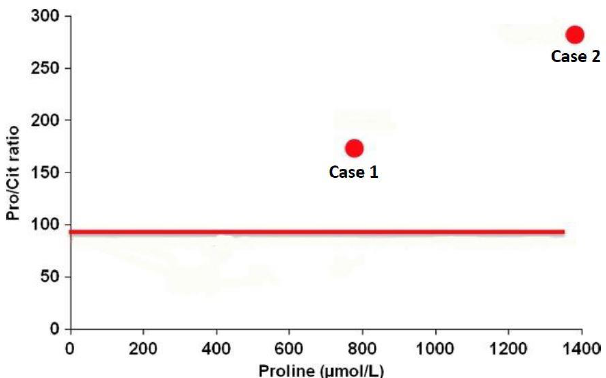
Figure 11. Proline/citrulline ratio and proline concentration in the neonatal dried blood spot of two affected patients with OAT deficiency (case 1 and case 2). The solid line indicates the 99 percentile (97.6) of > 450,000 blood spot samples analyzed as part of the Minnesota NBS program. Adapted from de Sain-van der Velden et al. [229].